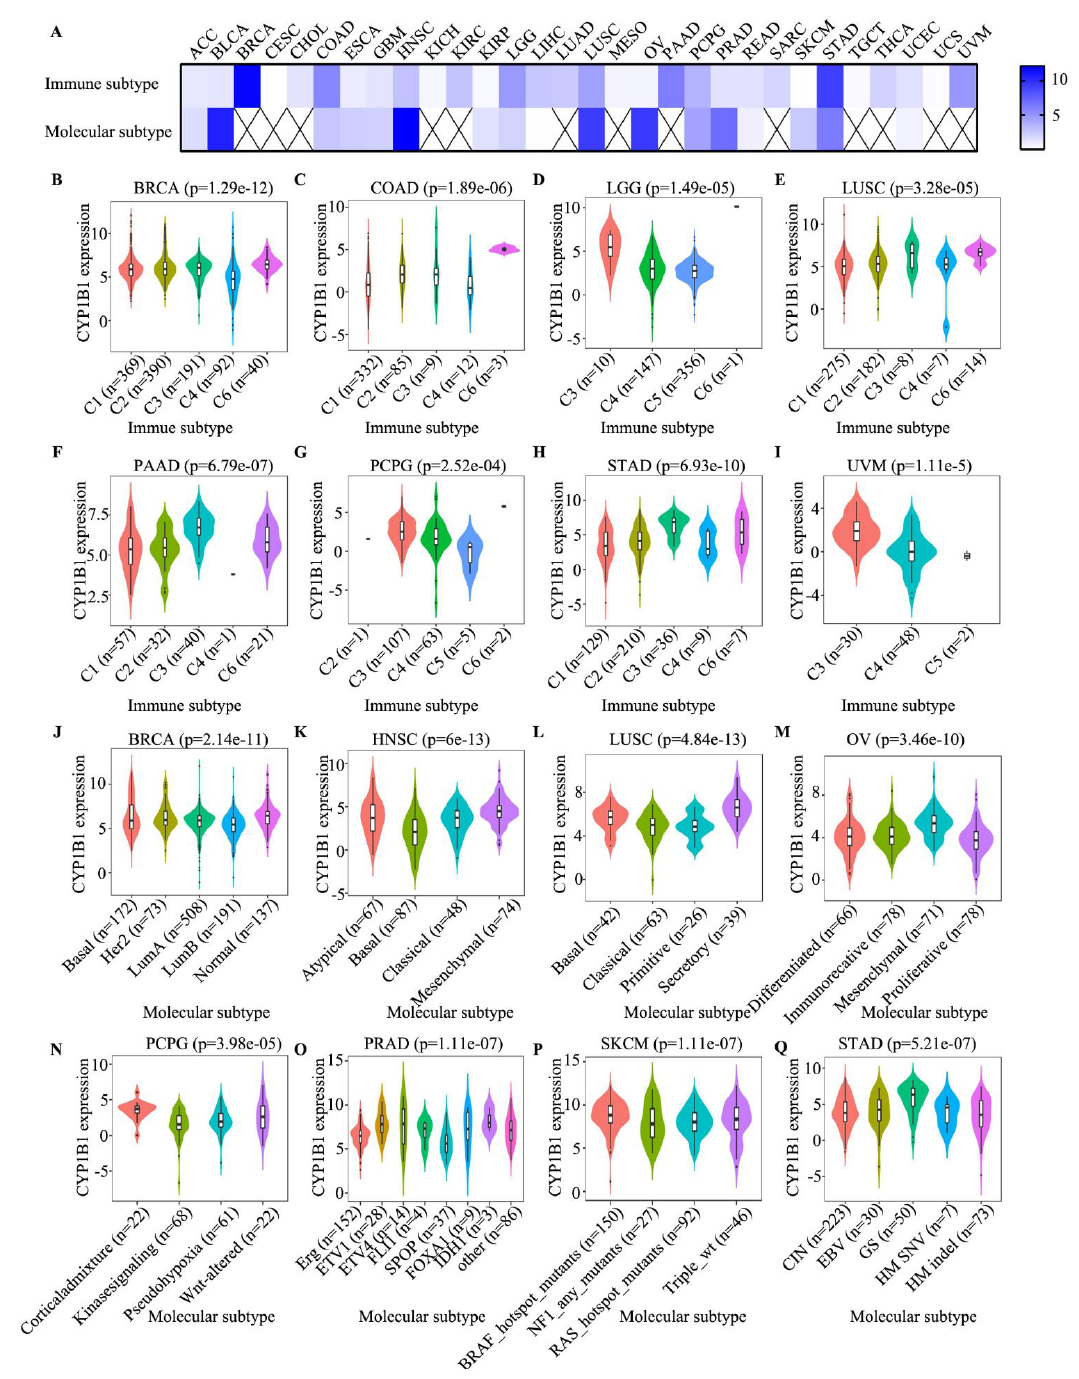
Figure 7. The associations between CYP1B1 expression and immune subtype and molecular subtype. ( A ) The heatmap of the Kruskal–Wallis test in the immune subtype and molecular subtype. ( B – I ) The top eight correlations between CYP1B1 expression and immune subtype in BRCA ( B ), COAD ( C ), LGG ( D ), LUSC ( E ), PAAD ( F ), PCPG ( G ), STAD ( H ), and UVM ( I ). ( J – Q ) The top eight correlations between CYP1B1 expression and molecular subtype in BRCA ( J ), HNSC ( K ), LUSC ( L ), OV ( M ), PCPG ( N ), PRAD ( O ), SKCM ( P ), and STAD ( Q ) (Kruskal–Wallis test, p < 0.05 was considered to be